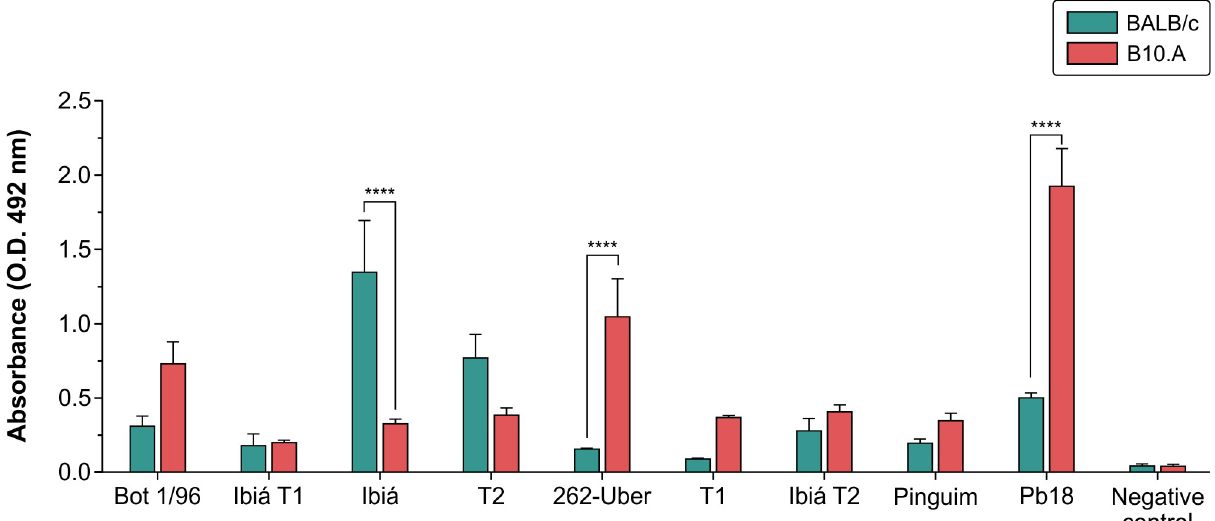
Fig 3. Anti-gp43 antibody detection. The levels of anti-gp43 antibody were determined in sera from B10.A and BALB/c mice by ELISA. Groups of five mice each were inoculated intratracheally with 10 6 P . brasiliensis yeast cells. Serum samples were obtained by tail vein bleeding at the 30 th day post- infection. Serum samples from non-infected mice were used as negative control. Data are representative of two independent experiments and values are expressed in mean ± SD. Statistical significance of differences is indicated as follows: ���� P < 0.0001, Tukey’s test.